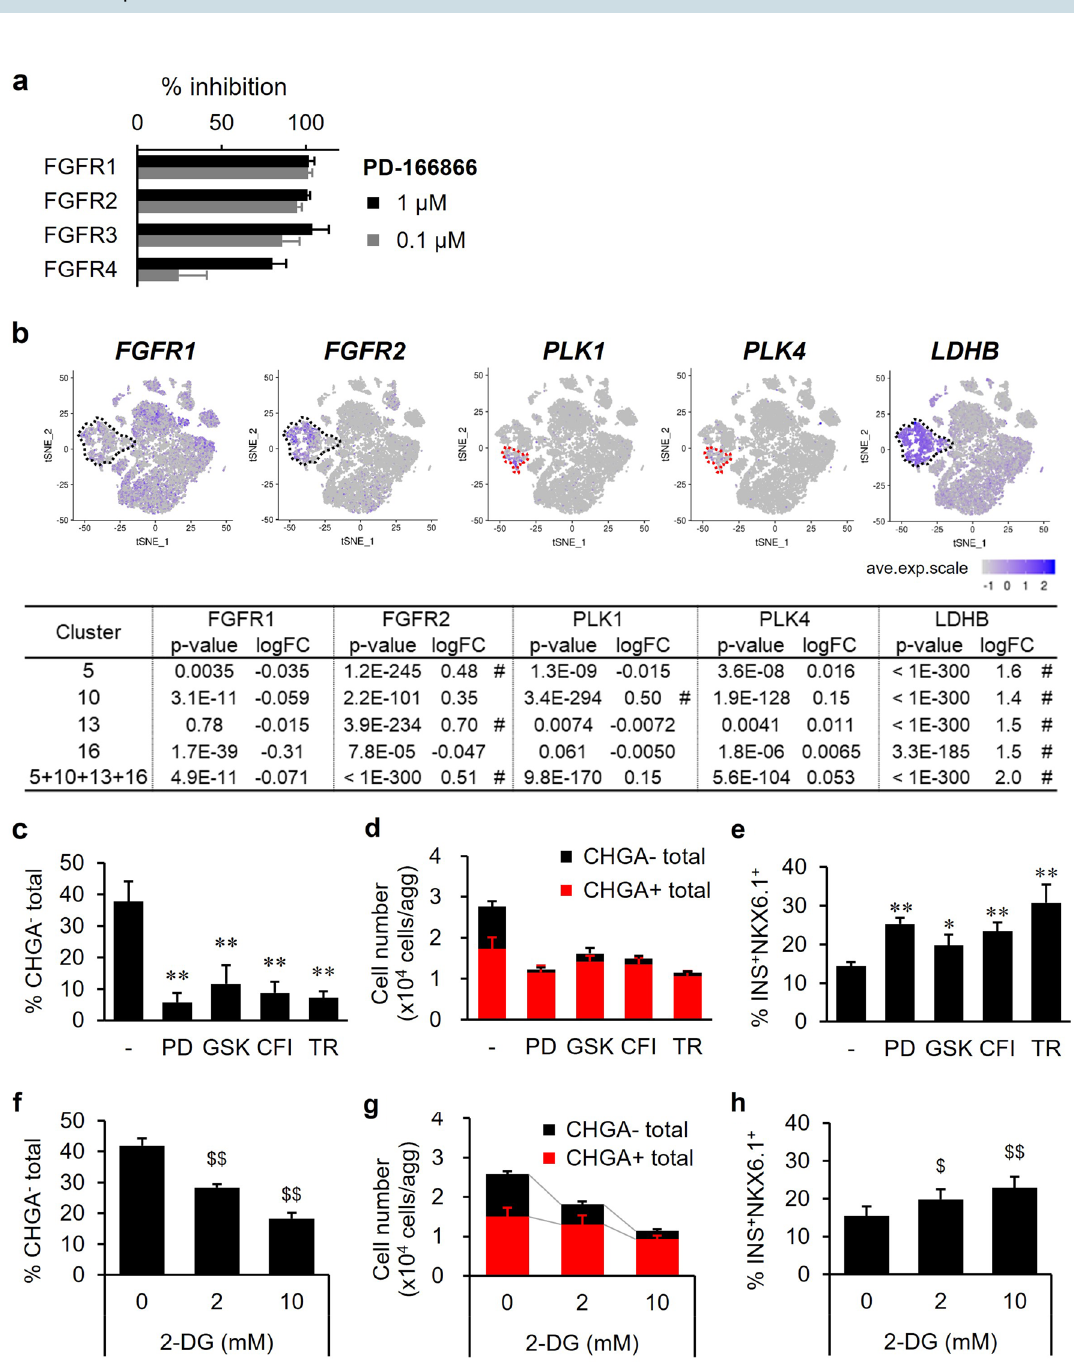
Figure 4. Reduction of the number of non-endocrine cells by inhibition of non-endocrine specific factors. ( a ) Inhibitory activities of PD-166866, known as a selective FGFR1 inhibitor, for all four FGF receptor isoforms in the TR-FRET-based competitive binding assay. Data are shown as the mean ± SD (n = 4, collected from independent experiments). ( b ) Single-cell gene expression analysis showing that FGFR1 , FGFR2 , PLK1 , PLK4 and LDHB were specifically expressed in non-endocrine clusters. The dotted line in black represents the non-endocrine population from the iPICs. The dotted line in red represents proliferative cluster 10. The table contains the p -value and fold change for each indicated non-endocrine cluster compared to the others. # for p -values less than 0.05 and fold changes more than 1.5. See Supplementary Fig. 8a for single cell gene expression of other FGFR and PLK isoforms. ( c–h ) Evaluation of the non-endocrine cell reduction effects of kinases and glycolytic inhibitors. S6-iPIC-B cells were additively treated with the indicated inhibitors from day 4 at stage 6 for purification and then collected and analyzed for the ratios of putative non-endocrine cells (CHGA - ) ( c,f ), cell number ( d,g ) and the ratios of putative β-cells (INS + NKX6.1 + ) ( e,h ). Data are shown as the mean ± SD (n = 4–5, collected from independent experiments). ** P < 0.01 versus s6-iPIC-B, Dunnett’s test. $ P < 0.025, $ $ P < 0.005, versus s6-iPIC-B, one-tailed Williams’ test. PD; PD-166866, GSK; GSK 461364, CFI; CFI-400945, TR; TR06141363, 2-DG;